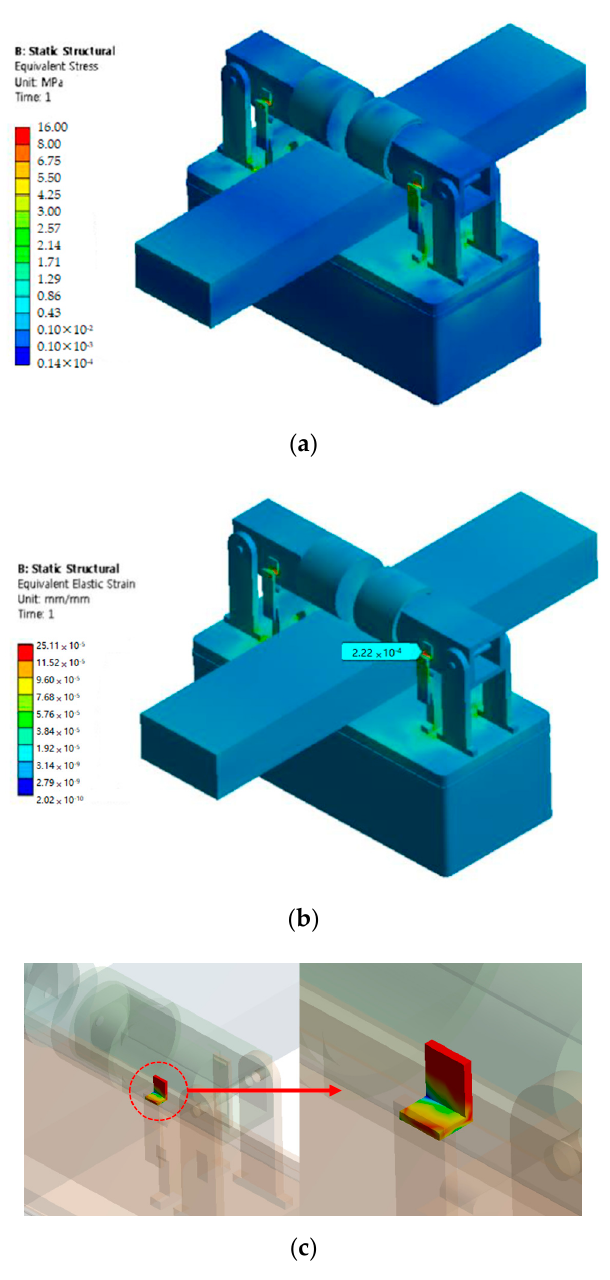
Figure 6. FEM results of the proposed overhang-type rail mover: ( a ) mechanical stress; ( b ) elastic strain; ( c ) safety